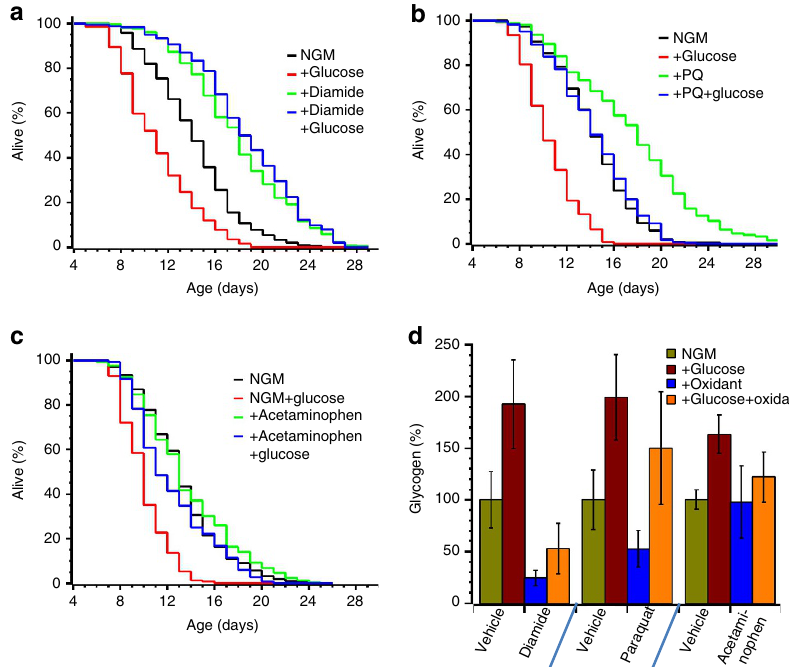
Figure 4 | Glycogen depletion by oxidants delays aging. ( a – c ) The short lifespan of glucose-fed C. elegans is reversed by 5mM diamide ( a ), 0.2mM paraquat ( b ) and 5mM acetaminophen ( c ). Half of L4 staged animals were placed on NGM plates þ / (cid:2) glucose (red and black curves), the other half was transferred to NGM plates þ / (cid:2) glucose supplemented with diamide ( a ), paraquat ( b ) or acetaminophen ( c ). For each graph, the average curve from three